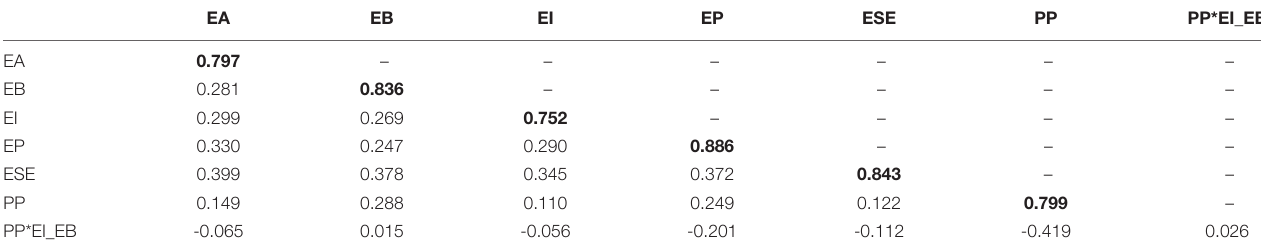
TABLE 2 | Fornell-Larcker Criterion.